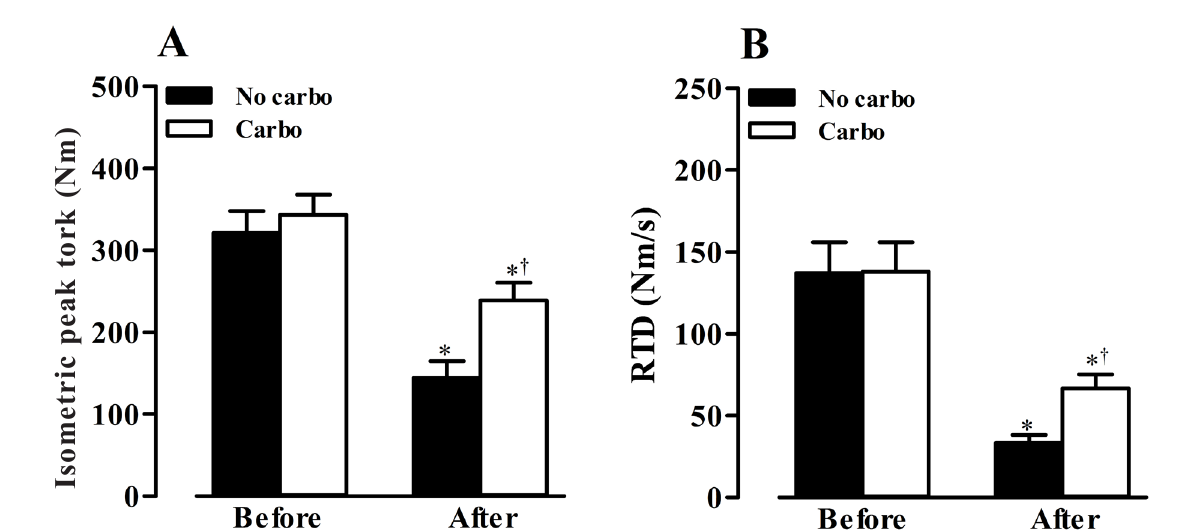
Figure 1. Values expressed in mean ± SD of isometric peak torque (panel A) and rate of torque development (Panel B) before and after fatigue induction protocol after placebo or carbohydrate supplementation intake.